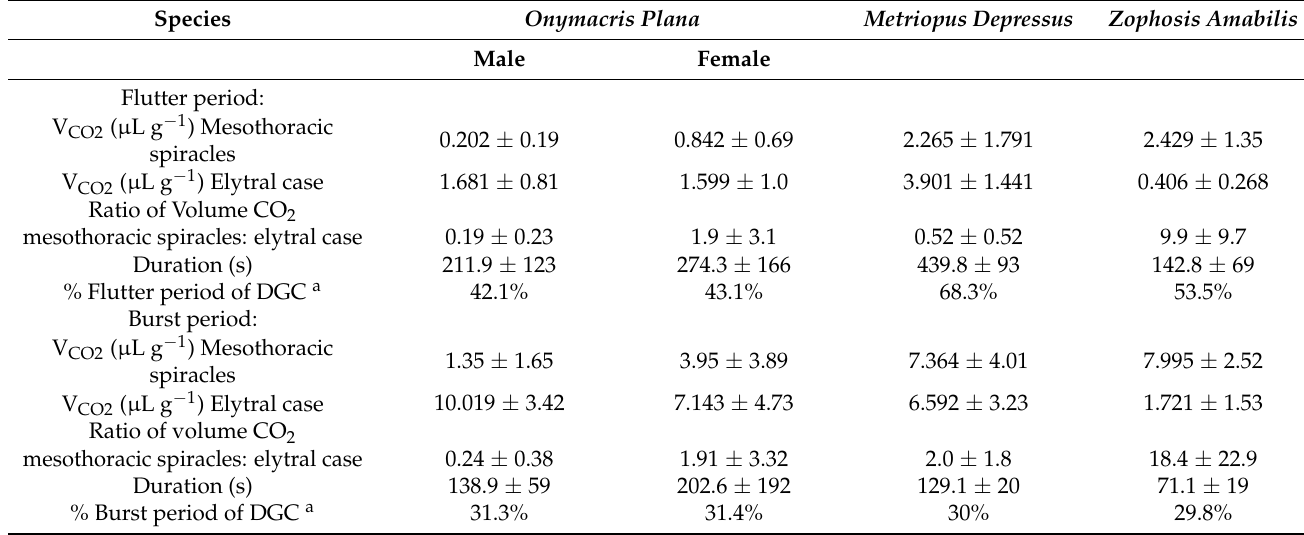
Table 2. Characteristics of the discontinuous gas exchange from the mesothoracic spiracles and elytral case of three Namib Desert tenebrionid beetles (mean ±